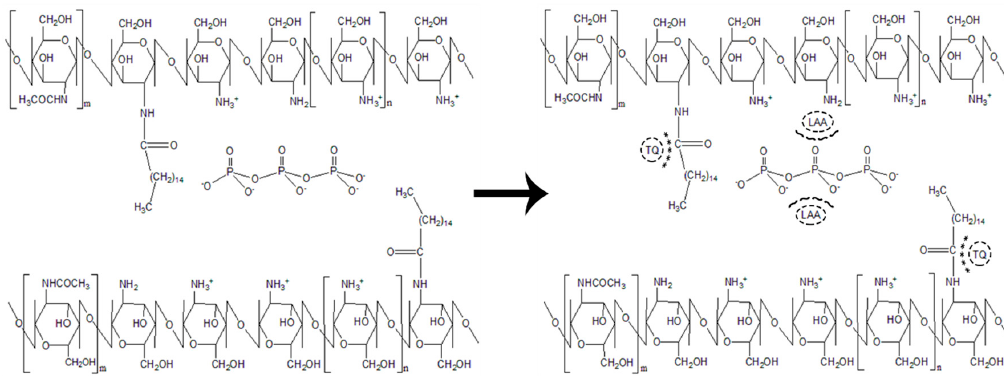
Figure 2. Proposed ionic interaction of pamiltoyl-chitosan nanoparticles, PCNP ( left ) and palmitoyl-chitosan nanoparticles encapsulated with thymoquinone and l -ascorbic acid, PCNP-TQ-LAA ( right ). “m” and “n” denote repetition of acetylated and deacetylated group of chitosan, respectively. ( * ) denotes hydrophobic–hydrophobic interaction between TQ and palmitic acid, while ( ~ ) denotes hydrophilic–hydrophilic interaction between l -ascorbic acid and tripolyphosphate.